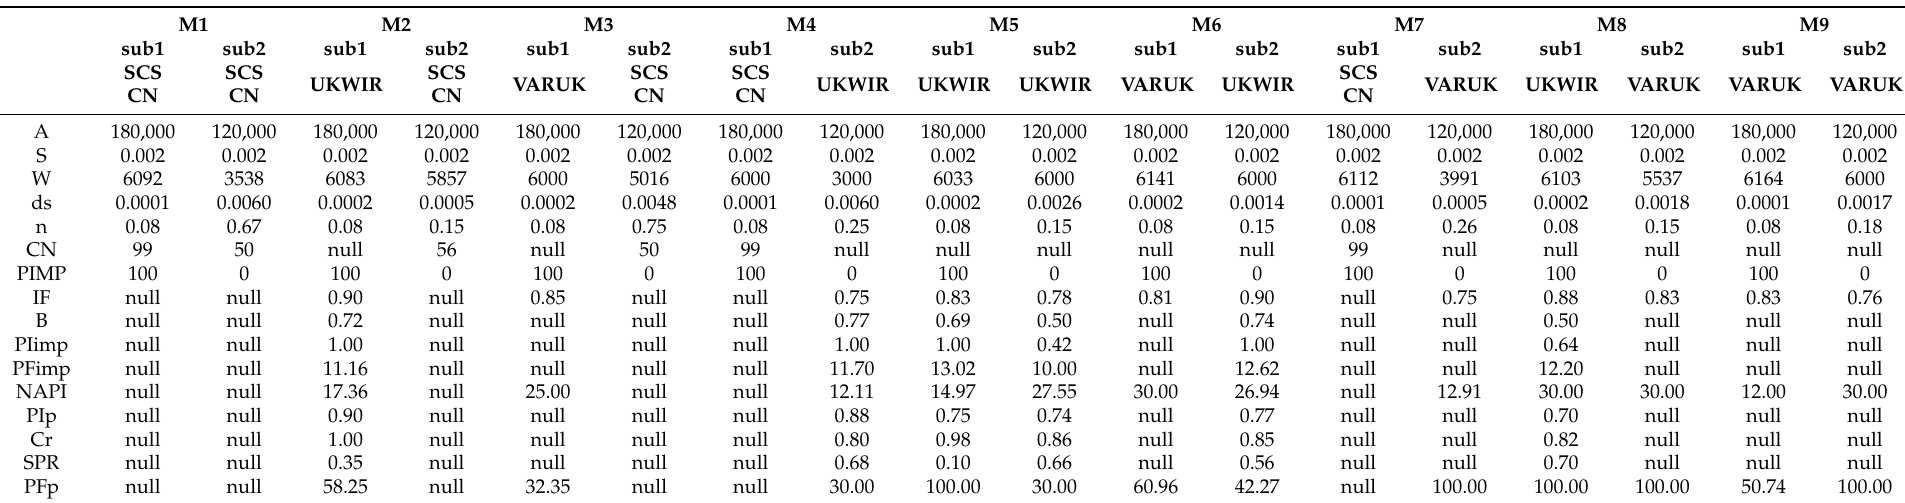
Table A1. The considered rainfall-runoff model structures with the calibrated values of their